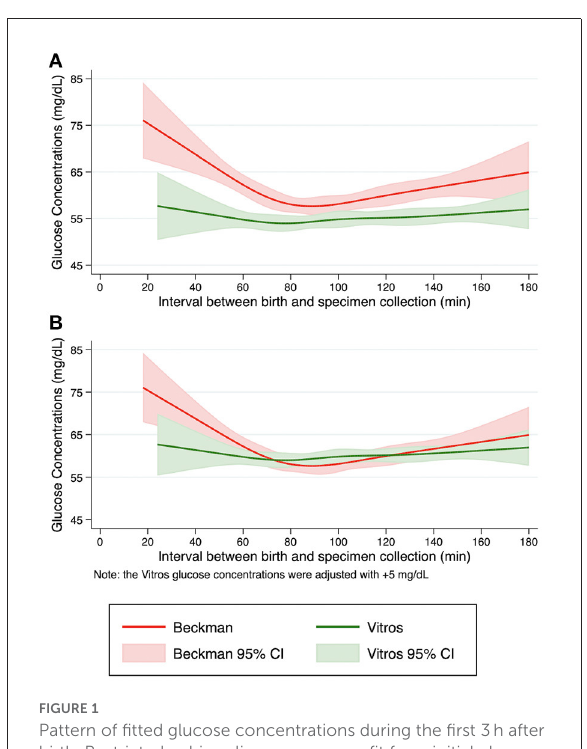
FIGURE1 Pattern of fitted glucose concentrations during the first 3h after birth. Restricted cubic spline curves were fit from initial glucose concentrations from term, appropriate size for gestational age newborns in the Beckman and Vitros Analyzers. (A) Fitted glucose concentrations and 95% confidence intervals from newborns using Beckman and Vitros Analyzers. (B) Fitted glucose concentrations and 95% confidence intervals from newborns using Beckman and Vitros Analyzers, after 5 mg/dL was added to the Vitros glucose concentration spline